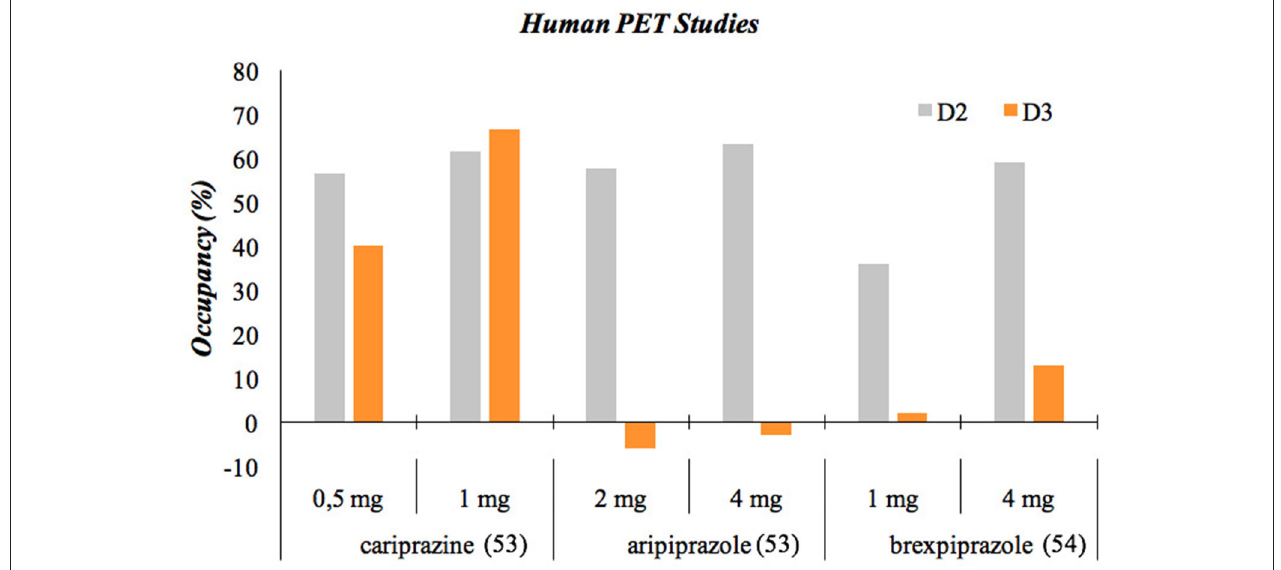
FIGURE 1 | Occupancy of D 2 and D 3 receptors of antipsychotics. The cariprazine and aripiprazole data come from a PET study involving healthy volunteers that aimed to assess the D3 receptor occupancy of cariprazine and aripiprazole at doses that attain similar D2 receptor occupancy by both drugs. This was assessed using two different methods, and the data presented here is the average of the outcome of these methods. The brexpiprazole data comes from a PET study involving schizophrenia patients.